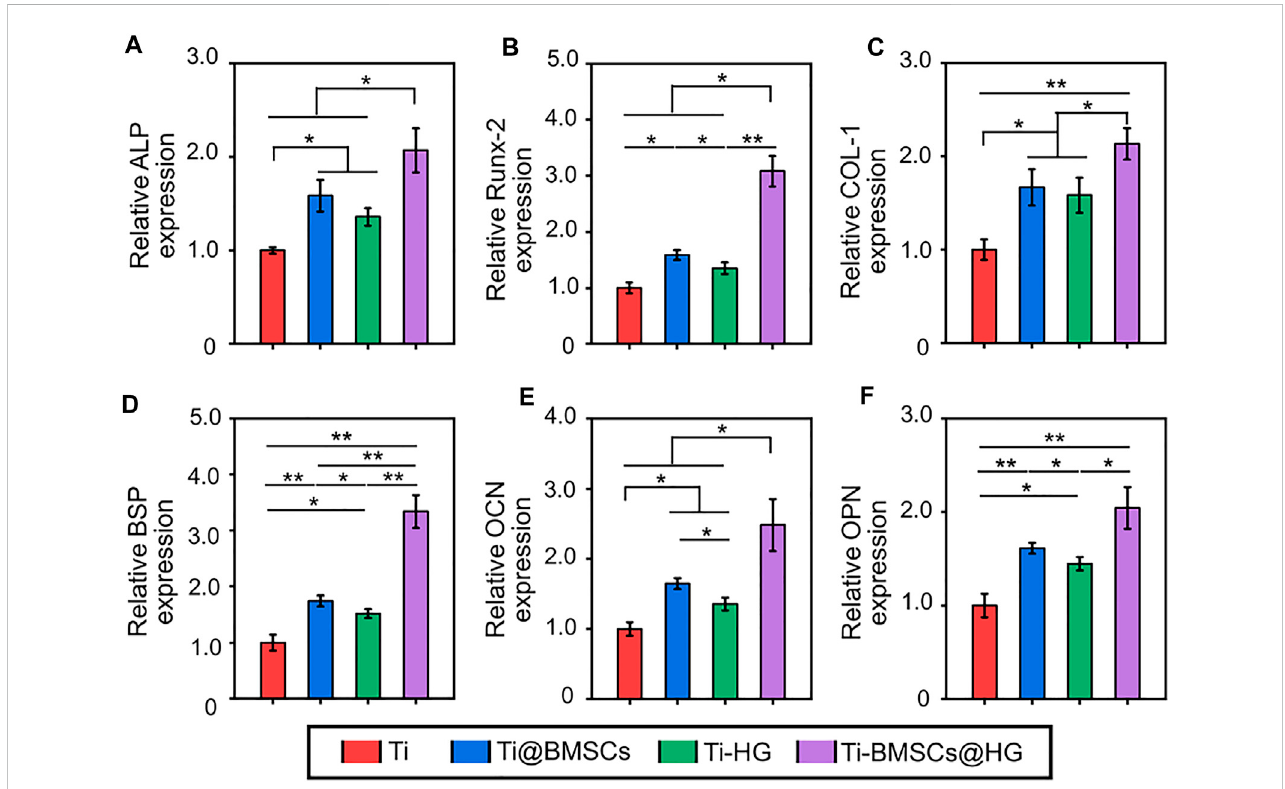
FIGURE 8 Expression of osteogenesis-related genes in bone tissues in the pores of porous prostheses, including (A) ALP, (B) Runx-2, (C) COL-1, (D) BSP, (E) OPN, and (F) OCN (* p < .05 and ** p <